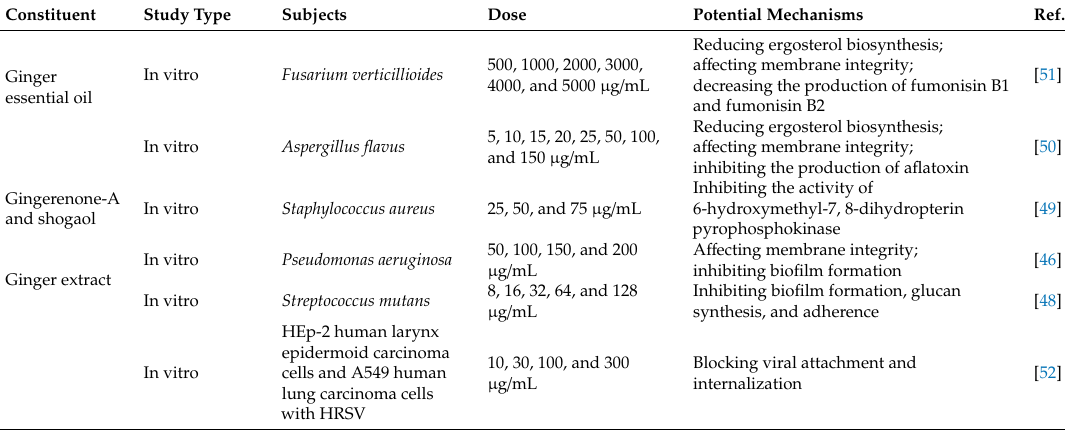
Table 3. Antimicrobial activity and potential mechanisms of